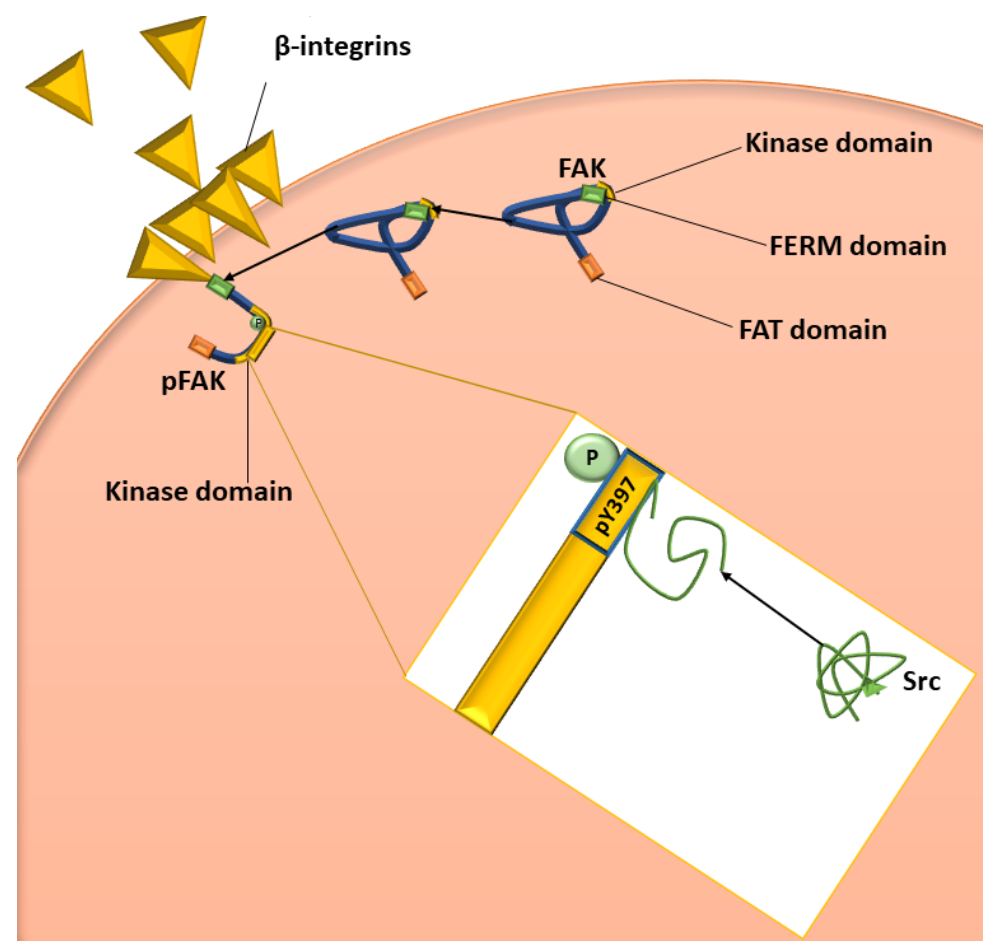
Figure 2. Diagrammatic representation of the activation of FAK and Src. The green bar on the blue FAK molecule represents the FERM domain, the orange bar represents the FAT domain, and the yellow bar represents the kinase domain. β -integrin clustering initiates FAK to bind to the cytoplasmic tail of the integrin, resulting in the unfolding of FAK, allowing autophosphorylation of pY397 (shown in the yellow box). Once FAK has been phosphorylated and therefore activated, Src can bind to pY397, which results in the unfolding of Src and, therefore, the activation of Src. Image was designed by DA Gomes using Microsoft ® Office PowerPoint (Microsoft Office enterprise 2007, 2006 Microsoft Corporation, Redmond, WA, USA).